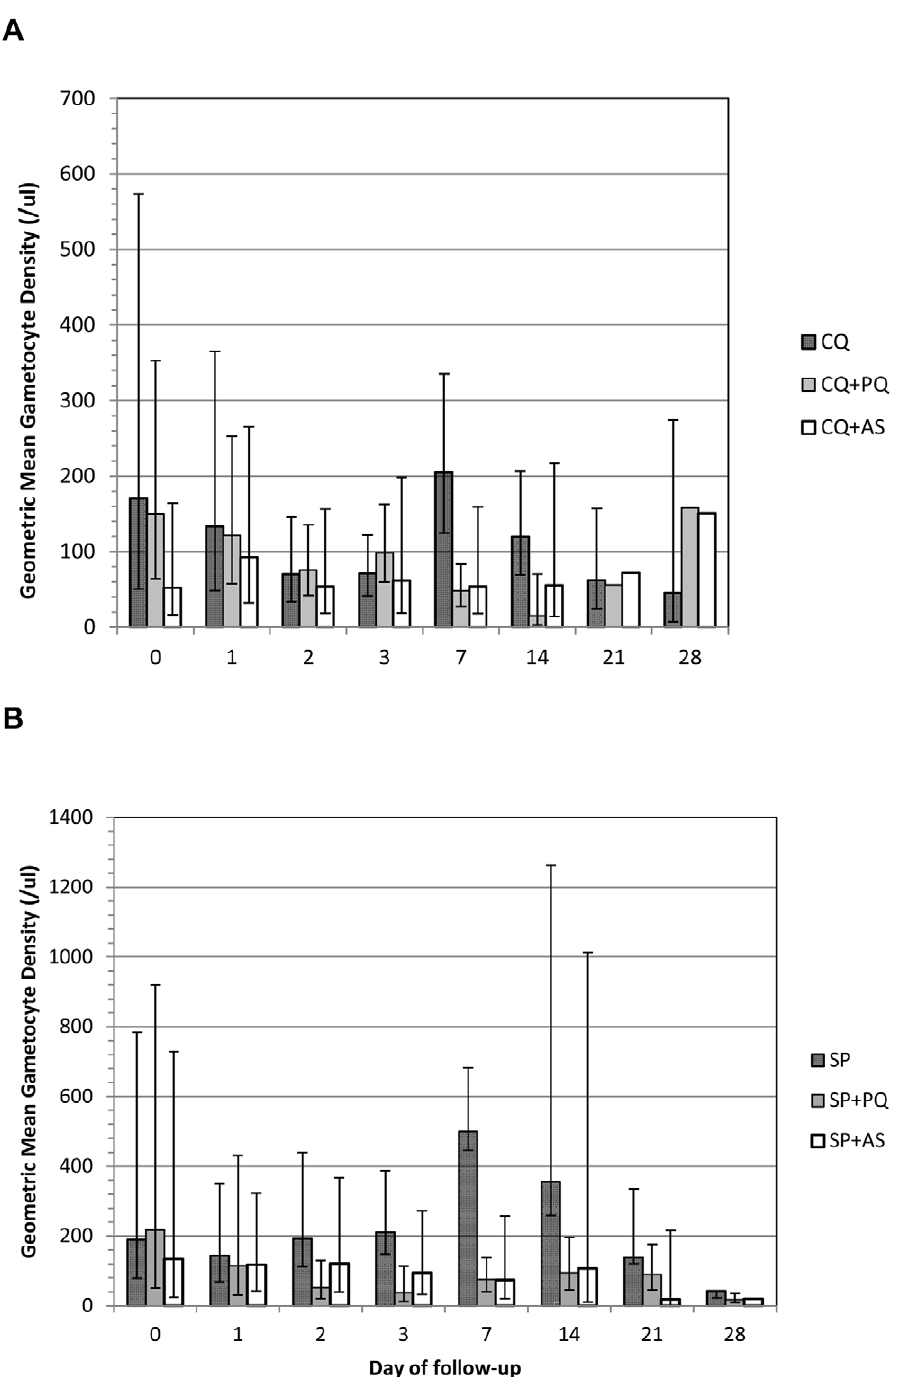
Figure 4. Geometric mean gametocyte density ( + CI) after treatment in chloroquine (A) and SP treatment arms (B). Note the different scales on the Y-axis. Where the CI bars are absent, only 1 patient had